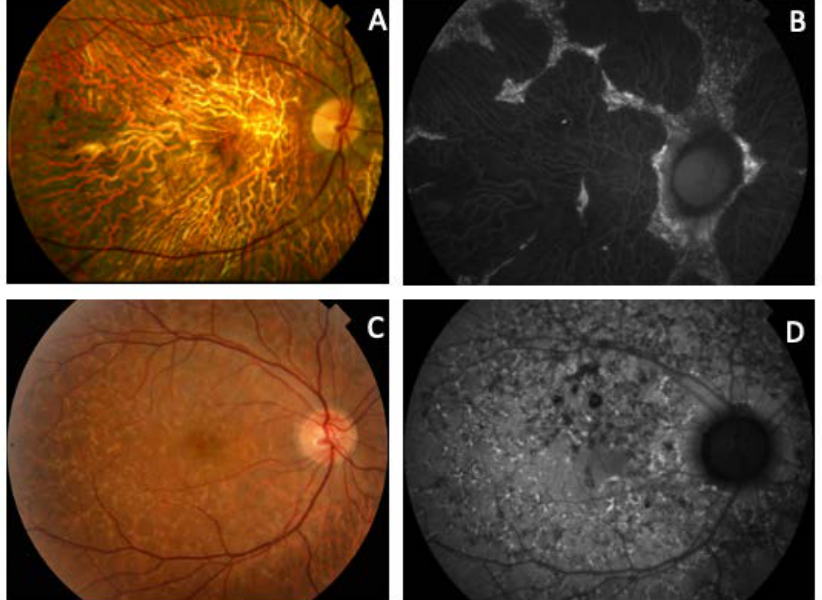
Figure 6. Clinical images from patients with mutations in the PRPH2 and ABCA4 genes. ( A ) Fundus and ( B ) autofluorescence of a case from F2-III-6 ( PRPH2 : p.Arg46Ter and ABCA4 : p.Leu2027Phe and p.Gly1977Ser) with the typical appearance of ECA and foveal preservation that explains the good